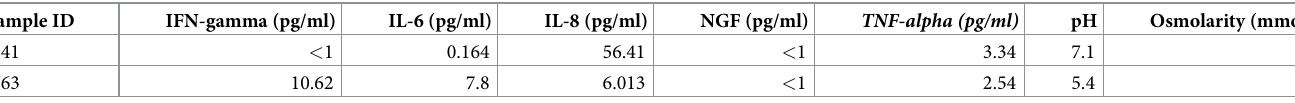
Table 1. Inflammatory markers and chemical parameters for U41 and